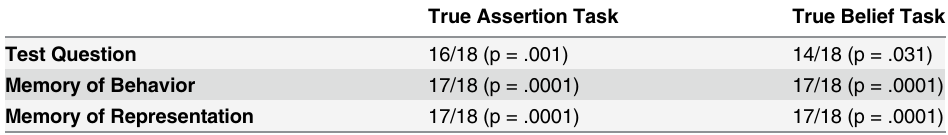
Table 2. Number of Successful Participants/Total Number of Participants (Comparison to chance by two-choice binomial test) on the Test question, Memory of Behavior, and Memory of Representation in the True Assertion Task and in the True Belief Task of Study 3.